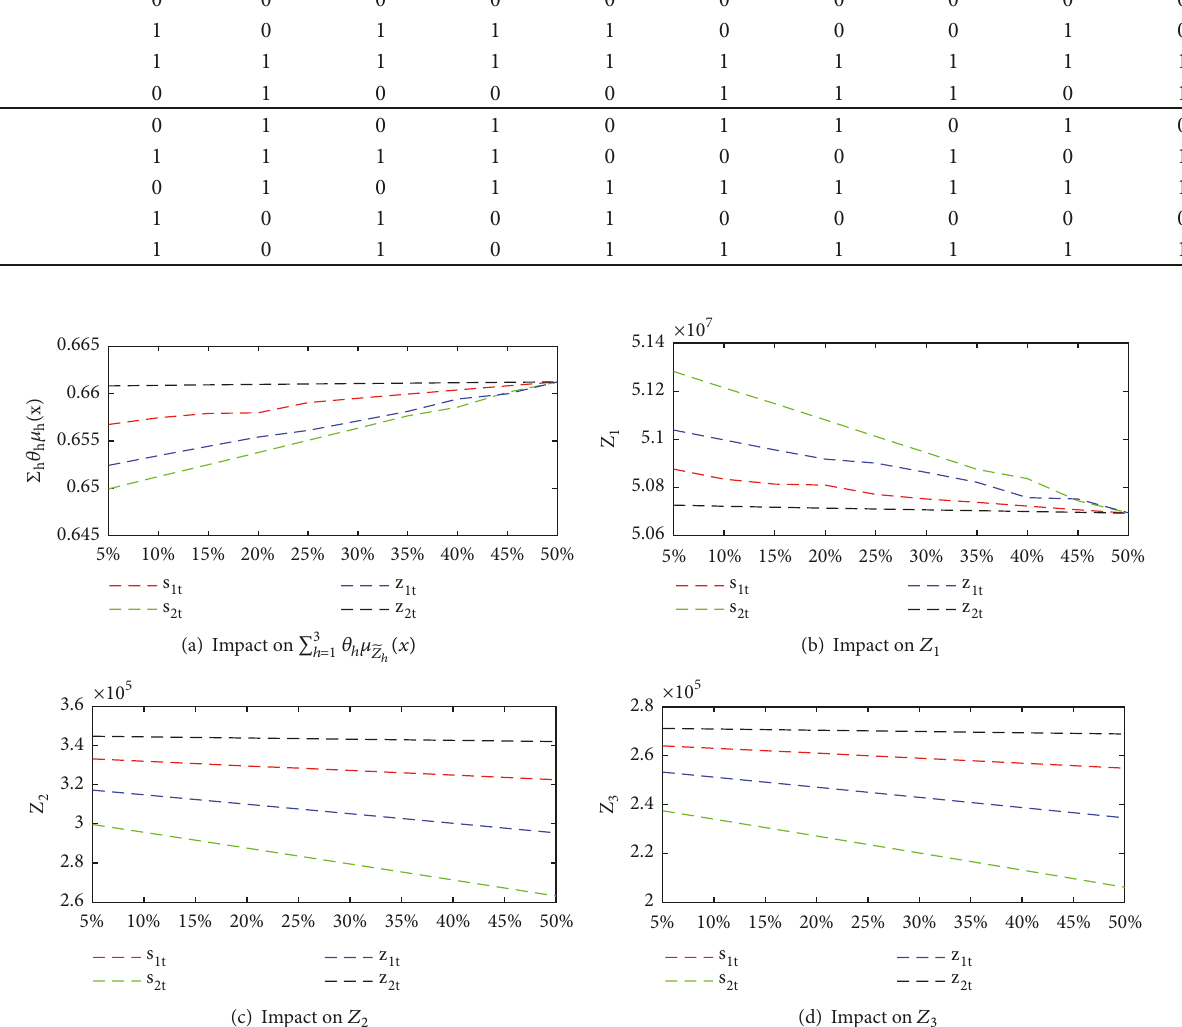
Figure 8: Sensitivity of selling price’s